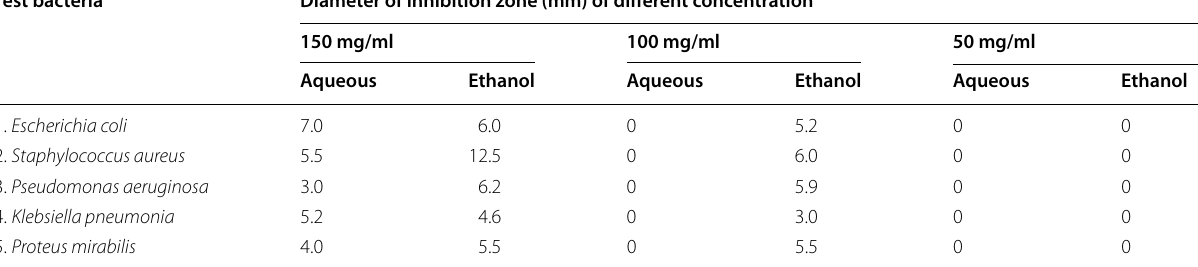
Table 2 Antibacterial activity of different concentrations of aqueous/ethanol extracts of A. sativum Test